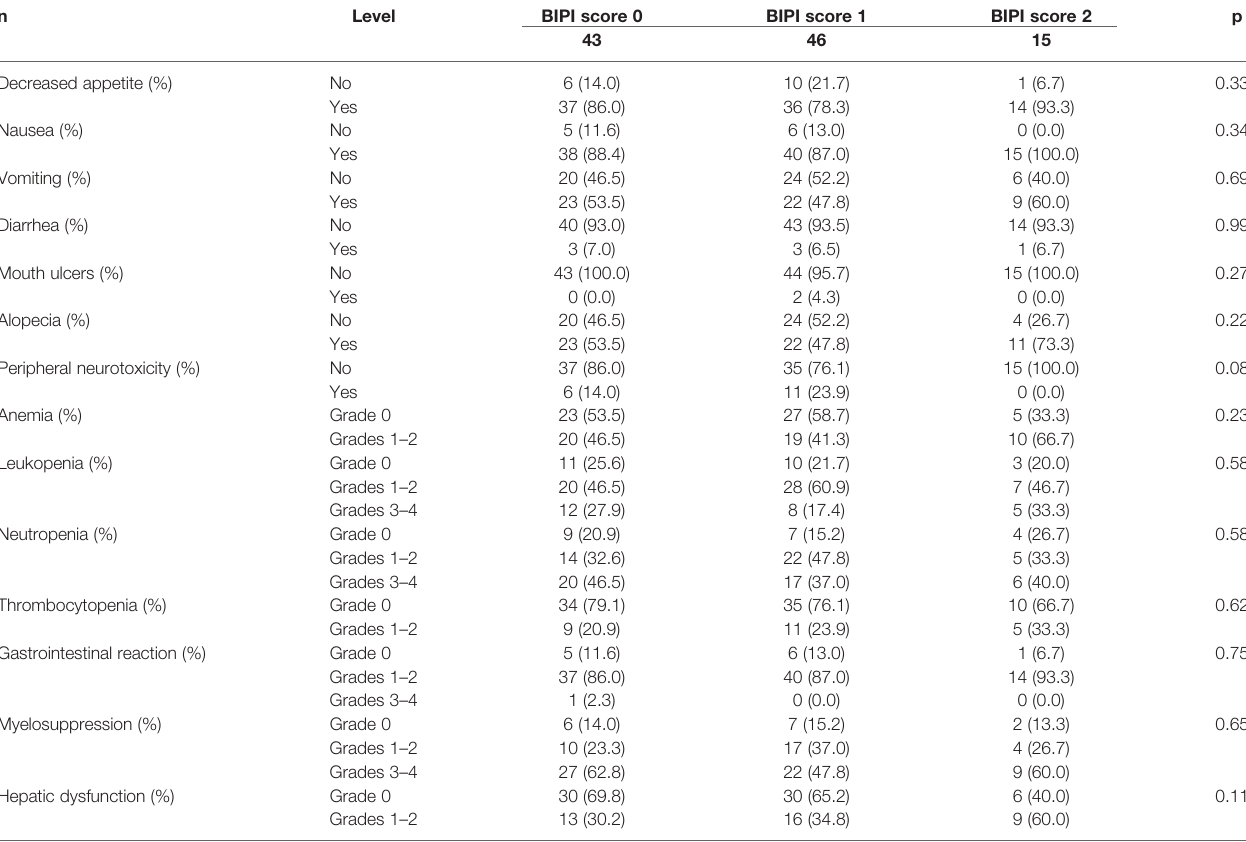
TABLE 4 | Patients ’ side effects of chemotherapy for all patients in accordance with breast immune prognostic index (BIPI).